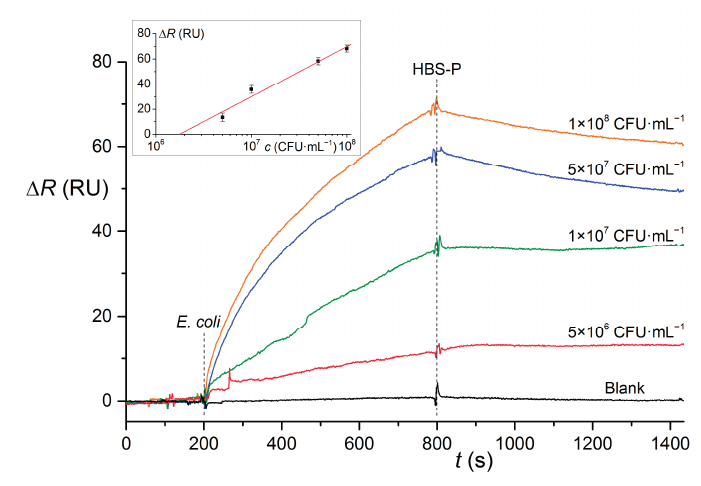
Figure 6. Binding interactions between E. coli DH5 α and antibody Abcam ab25823 studied using surface plasmon resonance. Changes of differential signal are shown. The inset graph represents calibration curve for SPR detection of E. coli DH5 α